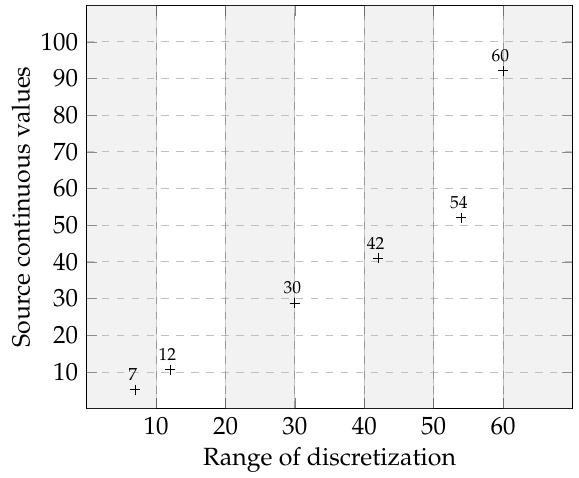
Figure 6. Data discretization